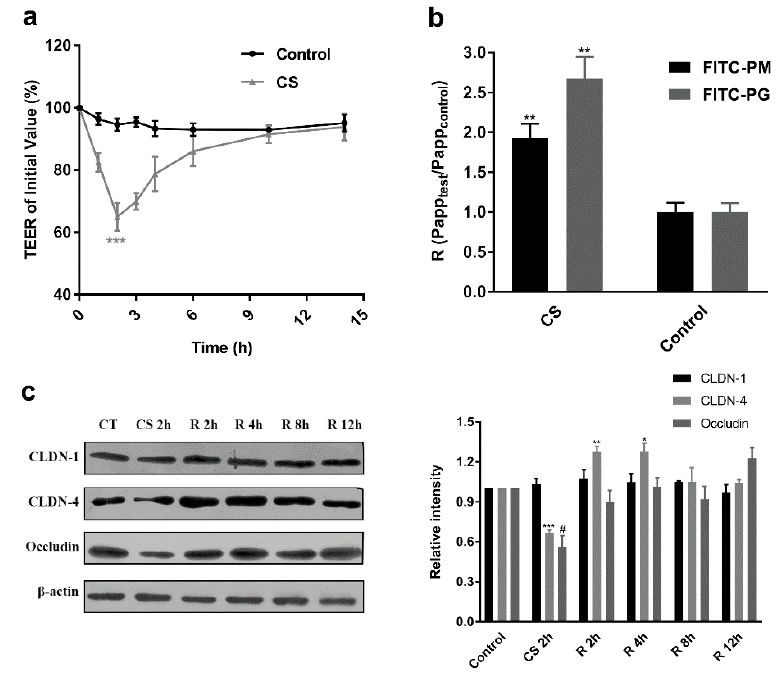
Figure 7. Effect of absorption enhancer on the transport of F-PM and F-PG in Caco-2 cell monolayers. ( a ) The effect of CS addition on TEER; ( b ) the effect of CS on F-PM and F-PG transport; ( c ) the effect of CS on tight junction proteins. * p < 0.05; ** p < 0.01; *** p < 0.001; # p < 0.05.